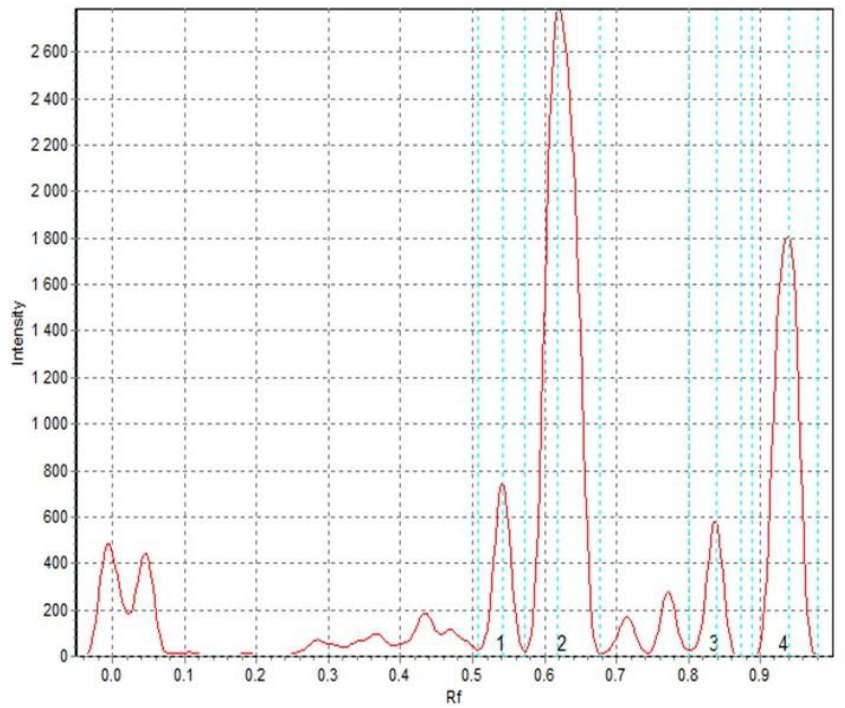
Figure 1. Example TLC chromatogram of compounds with the ability to scavenge DPPH radical (TLC-DPPH test) found in instant gruels with addition of 5% goji fruits; screw speed 100 rpm, plate scanned after 30 min.